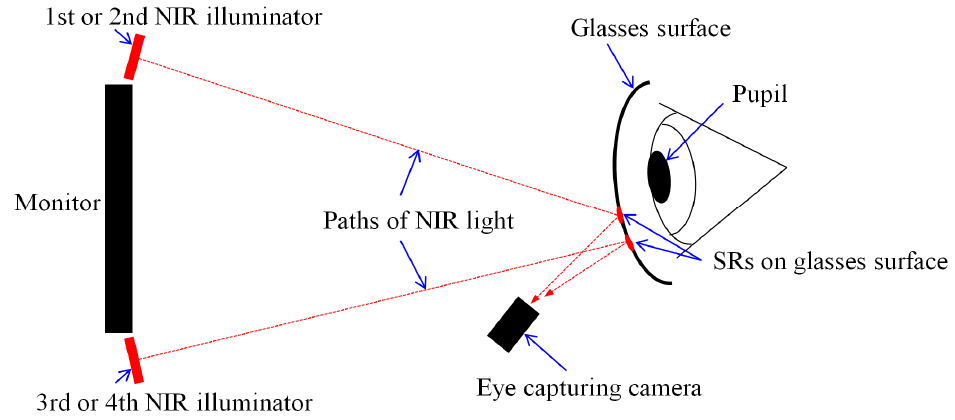
Figure 7. Conceptual diagram of the positions of the illuminators, the surface of the glasses, and the